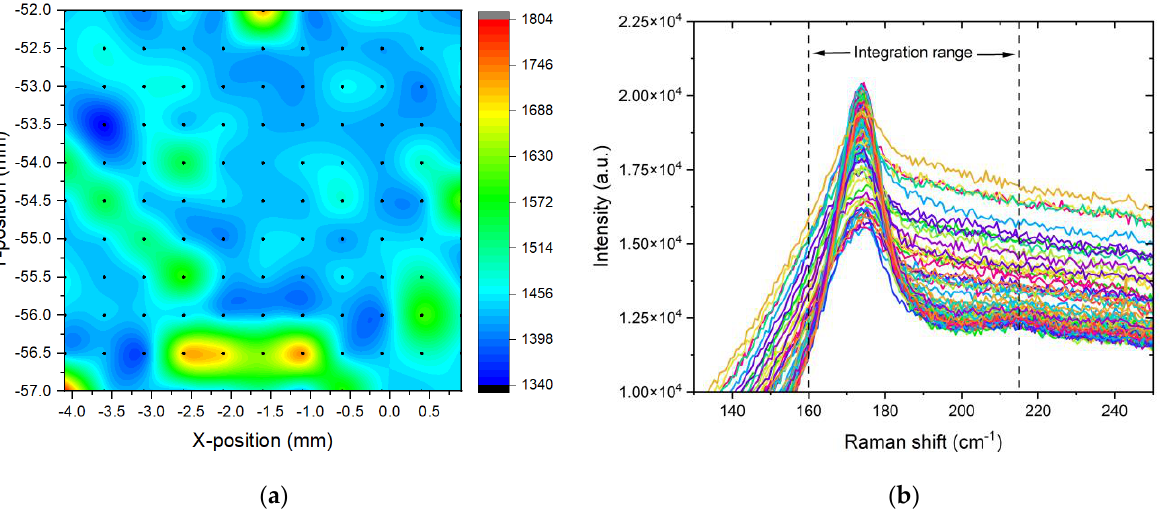
Figure 5. ( a ) Spatial distribution of Raman-shift for exemplary ACIGSe sample; ( b ) Individual Raman spectra integrated within the given wavenumber range to obtain the map in ( a ).